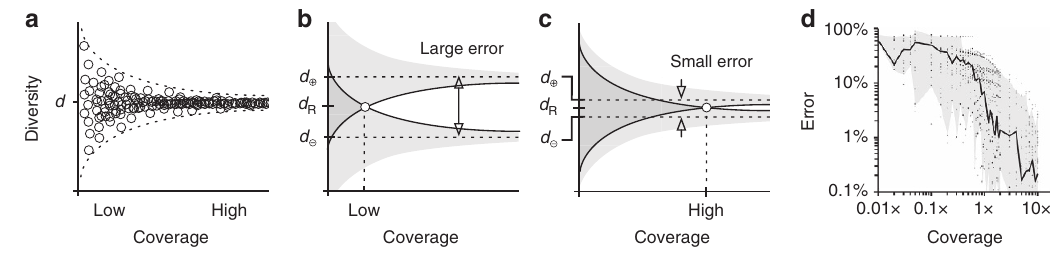
Figure 4 | Error bars. ( a ) A schematic representation of Recon’s diversity estimates (open circles) from a single gold-standard in silico repertoire with overall diversity d for many different levels of coverage ( ¼ sample size/ d ). We used the absolute value of the proportional error of the worst fit at each level of coverage, making an error profile that is vertically symmetric around d . Given a test sample, Recon first estimates the overall diversity, d R , and the coverage. ( b ) Using the error profile, it then looks up the maximum ( d " ) and minimum ( d ~ ) diversities that are consistent with its estimate ( d R ); schematically, this is where the edges of the funnel plots for d " and d ~ intersect. ( c ) Higher coverage gives smaller error (arrows). ( d ) Combining errors from all 1,711 gold-standard repertoires into a single plot suggests that Z 1x coverage generally gives error bars of 5–10% for species richness (line, median; shaded area, 5th–95th percentiles).